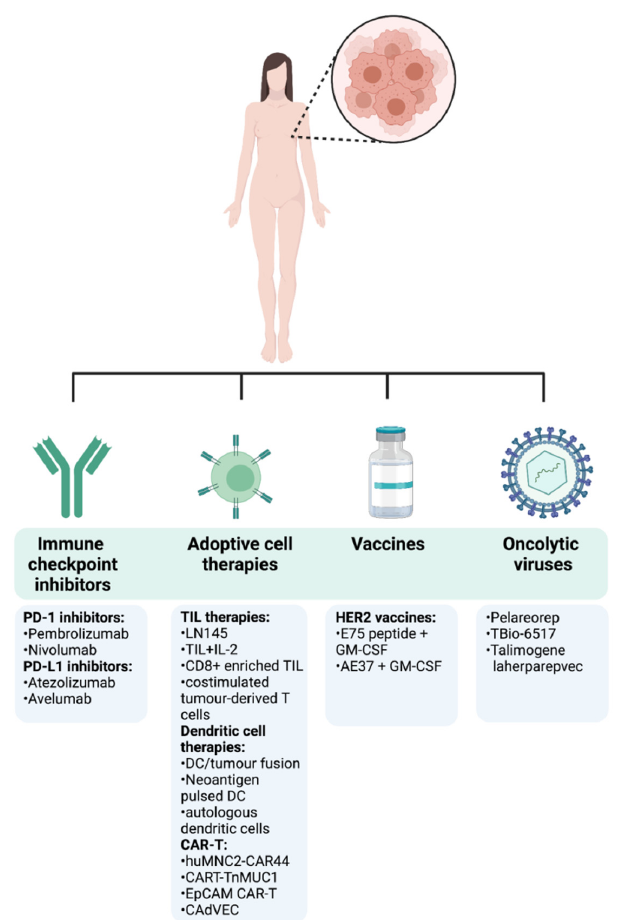
Figure 4. Immunotherapy approaches in breast cancer. The first cancer immunotherapy treatment entered the clinical